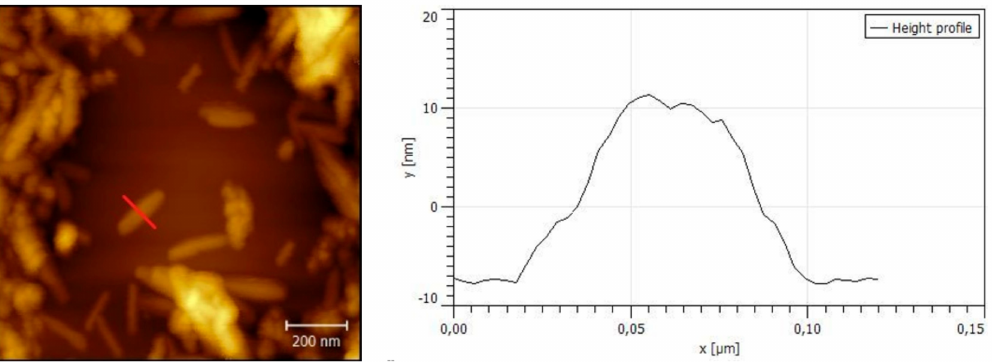
Figure 1. Atomic force microscopy image of graphene oxide (GO) captured on mica substrate together with height profile along the red line of interest on GO particle where the height is about 17 nm and lateral dimension about 200 nm in